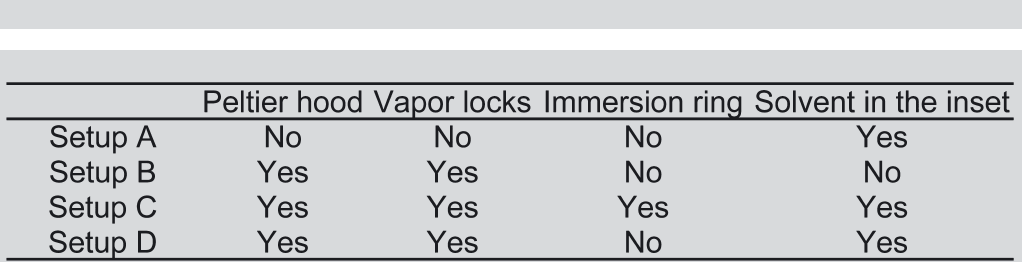
Table 2 (above): Setup of the evaporation blocking system for hydro- gel experiments Table 3: Setup of the evaporation blocking system for colloidal suspension